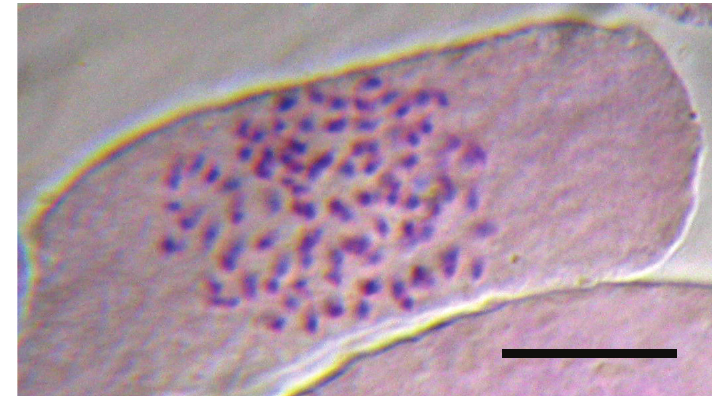
Figure 2. Genista tenorei G.Don, 2 n = 96. Scale bar: 10 μm. Observations. Genista tenorei is endemic to Italy, limited to the Pollino Massif and belonging to the complex of G. tinctoria L. Genista tenorei is morphologically very similar to the SE European G. depressa M.Bieb. (Bernardo and Peruzzi 2016). This